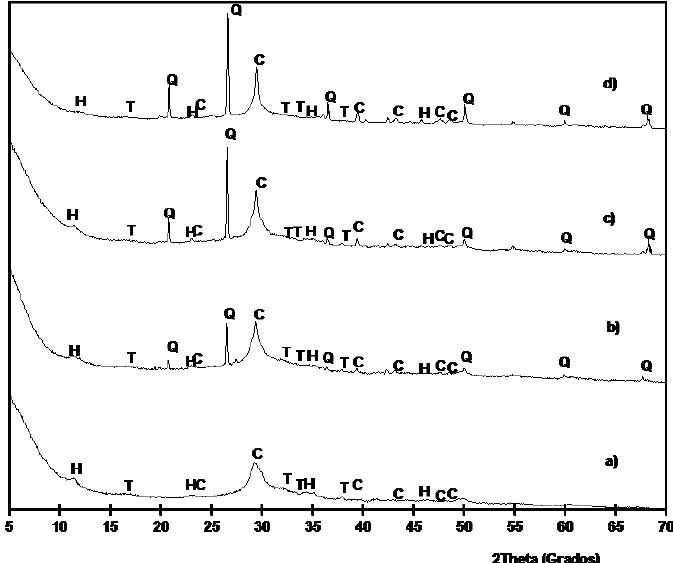
Figure 10. XRD diffractograms for BFS/SCBA pastes cured for 270 days at 20 °C: ( a ) 100/0; ( b ) 85/15; ( c ) 75/15; ( d ) 60/40. (Key: Q: Quartz; C: Calcite; T: Thermonatrite; H: Hydrotalcite).